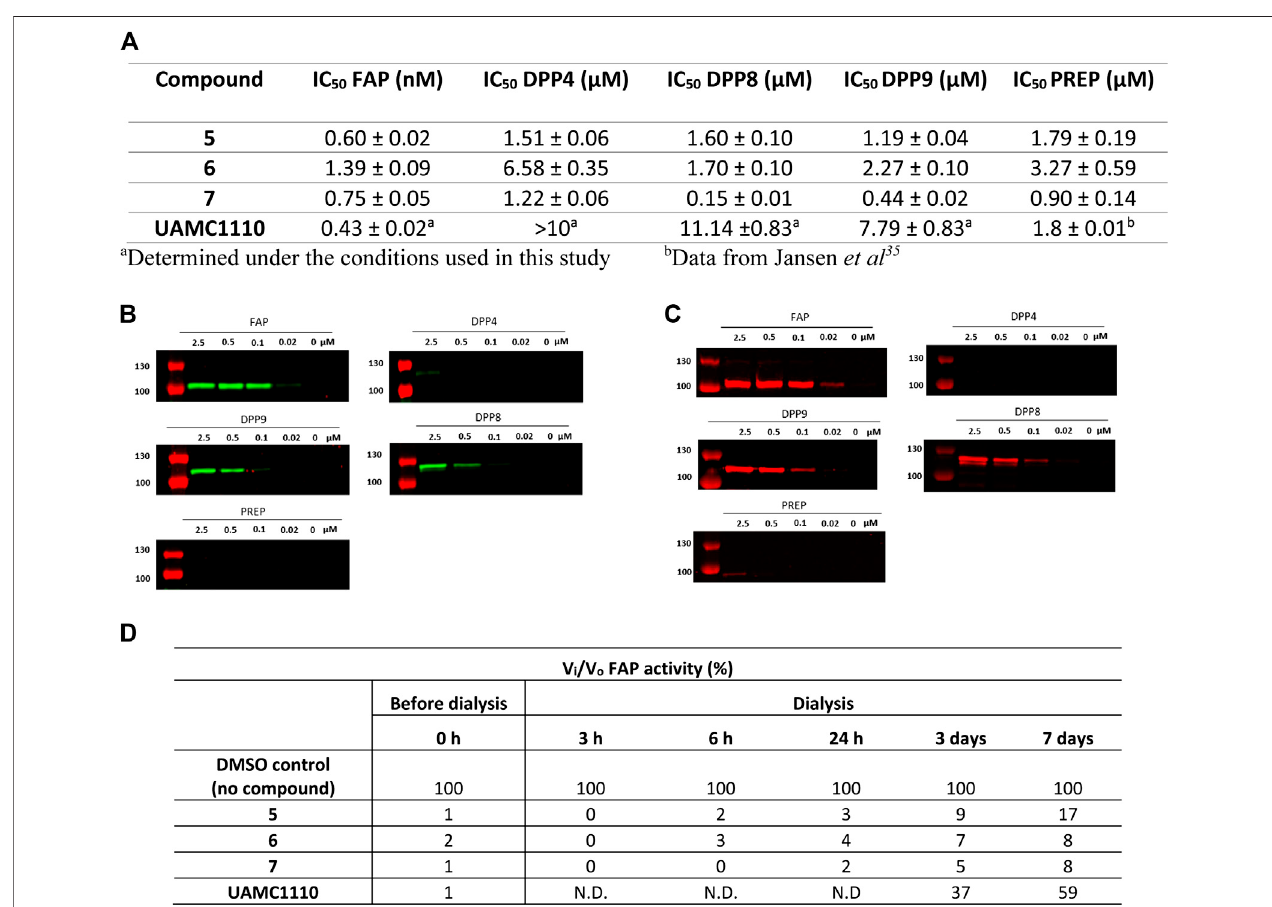
FIGURE2| Potency,selectivity,andirreversibilityoftheABPs( 5 , 6 ,and 7 )forFAP. (A) IC 50 valuesof 5 – 7 (biotin-,Cy3-,andCy5-activity-basedprobe)towardFAP and related peptidases (DPP4, DPP8, DPP9, and PREP). Experiments were carried out in triplicate ( n (cid:2) 3), and results are displayed as mean ± SD. Labeling of recombinant FAP, DPP4, DPP8, DPP9, and PREP using 6 (Cy3-labeled) (B) and 7 (Cy5-labeled) (C) probes. Enzymes (100 nM fi nal concentration) were incubated separately with various probe concentrations for 20 min and then subjected to SDS-PAGE analysis. (D) Dialysis experiment to investigate reversibility of the developed probes ( n (cid:2) 2). N.D.: not